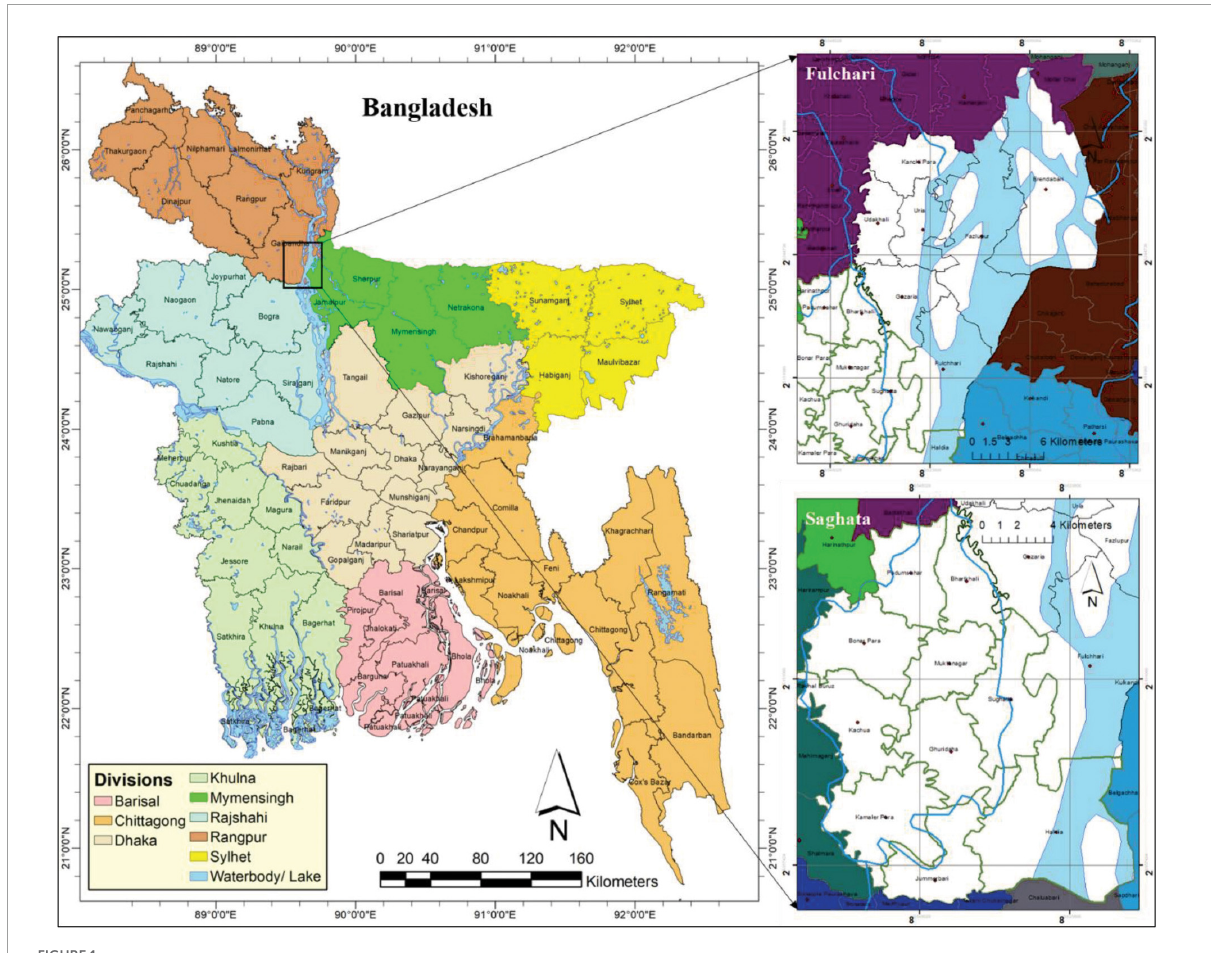
FIGURE1 Location of the study